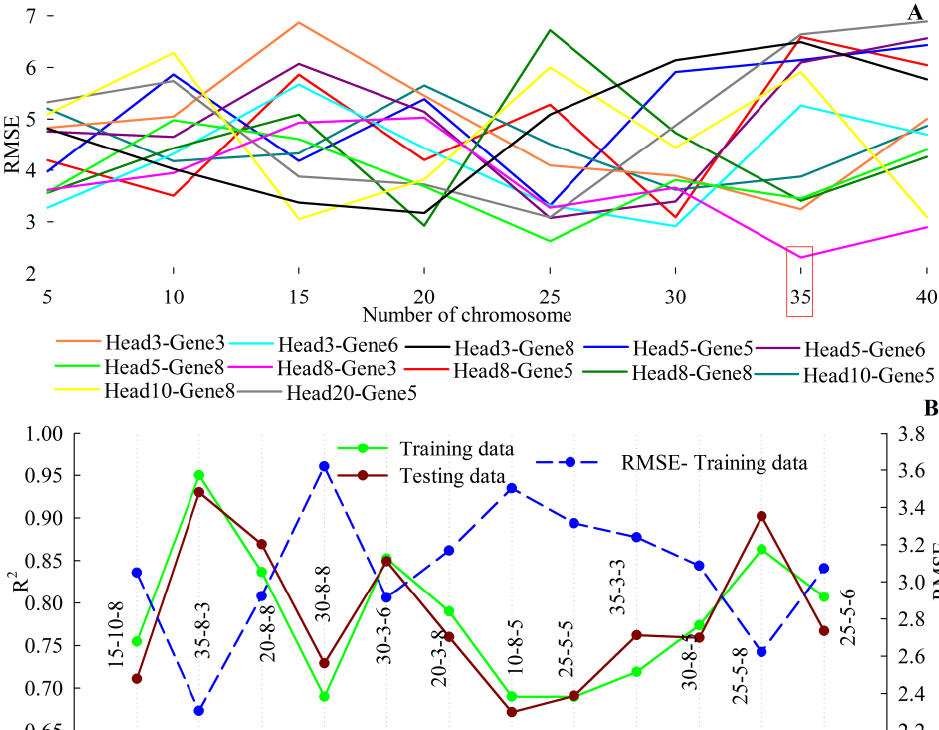
Figure 6. ( A ) Variation of RMSE for series parametric analyses using different head size and genes based on the number of chromosomes, ( B ) evaluated candidate models using RMSE and R 2.